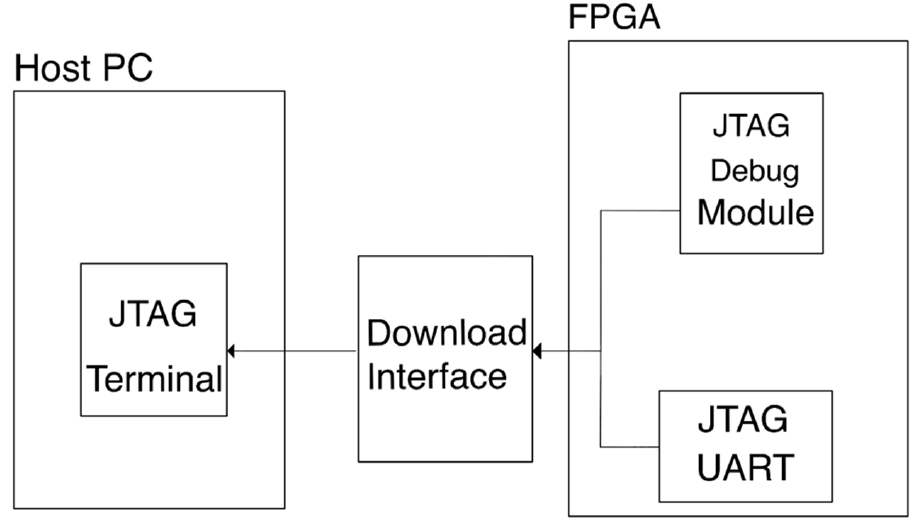
Figure 8. A conceptual diagram of the communication between an FPGA and a host.